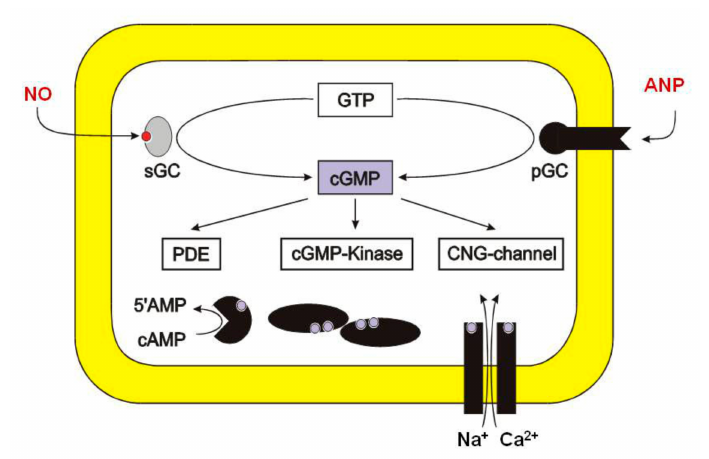
Figure 5. Activation of soluble guanylyl cyclase by nitric oxide. Source: https://commons.wikimedia. org/w/index.php?curid=15680898, accessed on 22 June